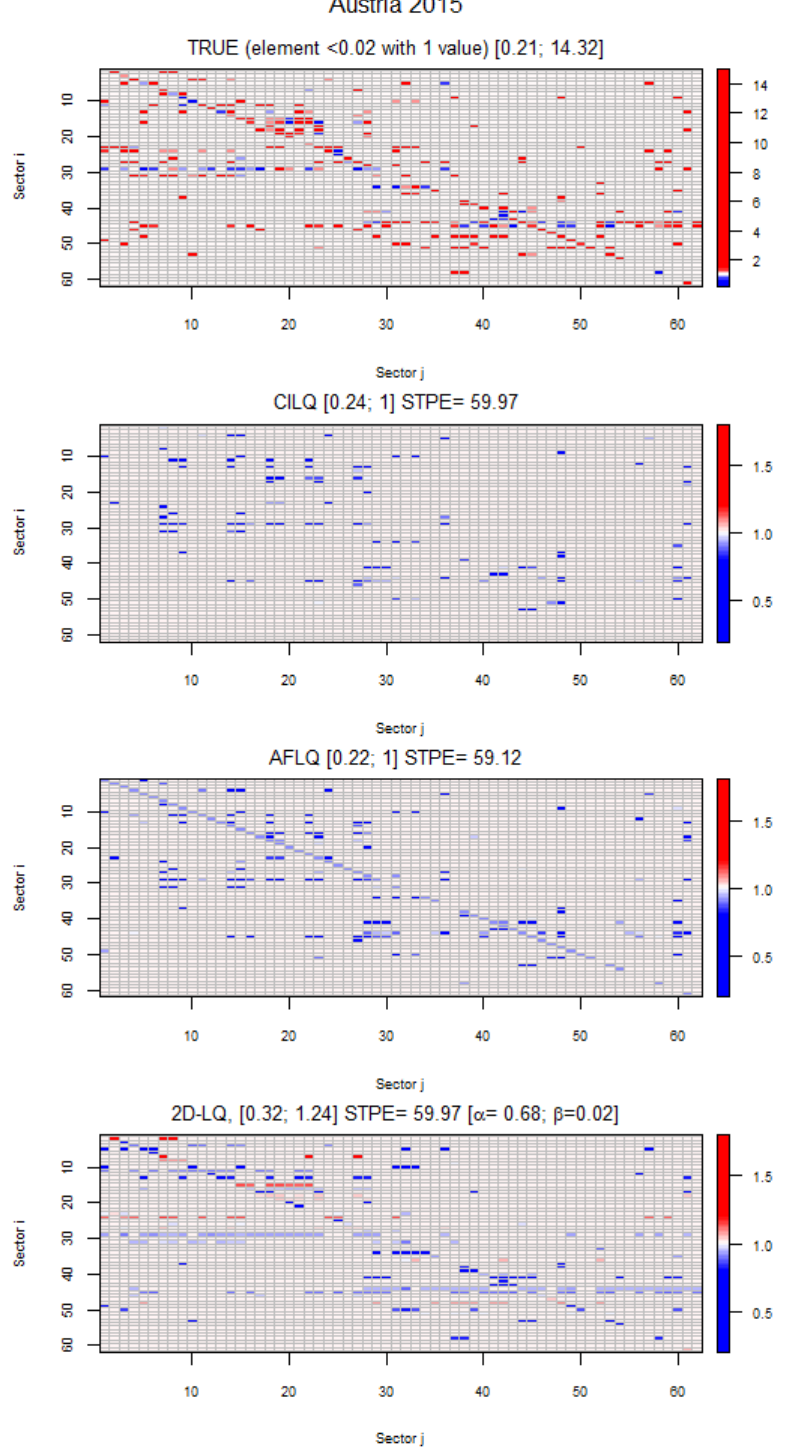
Figure 2. Projections of technical coefficients via LQ versus ideal rectifications (Austria). Source: internal based on Eurostat data [naio_10_cp1700].